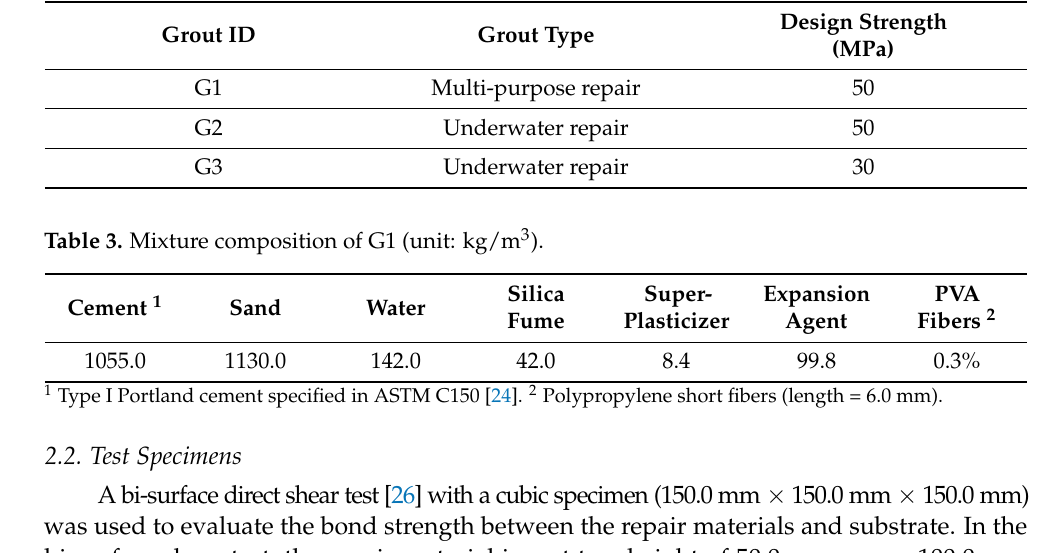
Table 2. Design strength and manufacturer of cementitious grouts.